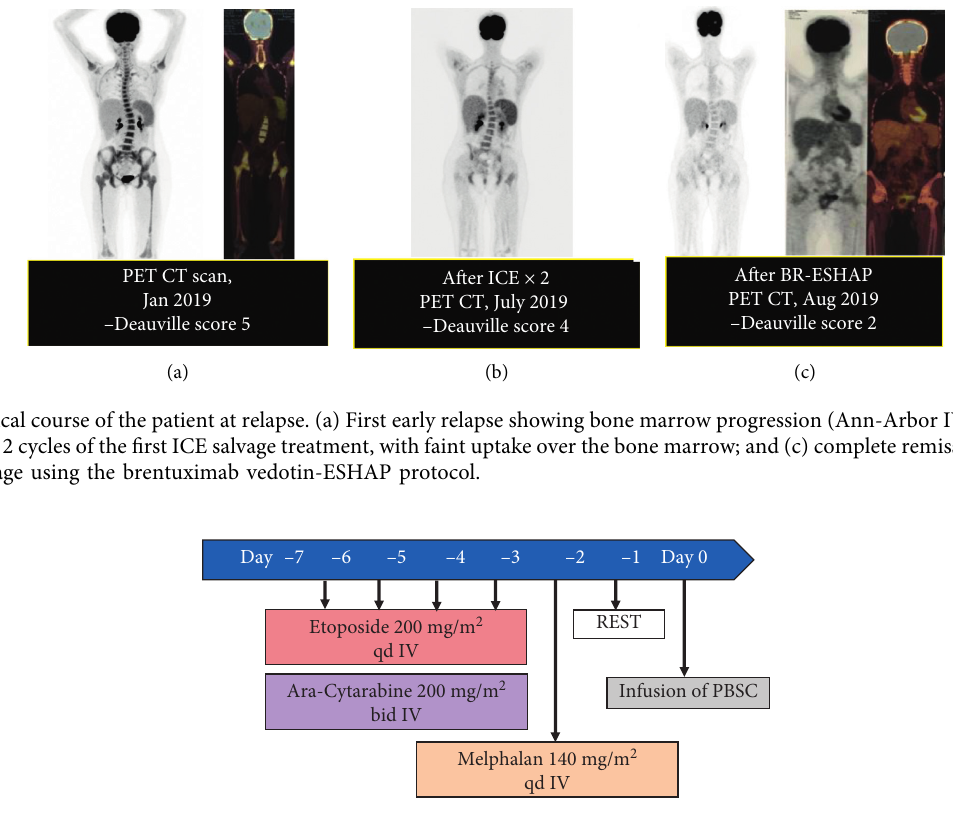
Figure 3: EAM protocol scheme at glance. Preharvested autologous stem cells were infused after 1 full day rest without chemotherapy (day zero). BMT, bone marrow transplantation; PBSC, peripheral blood stem